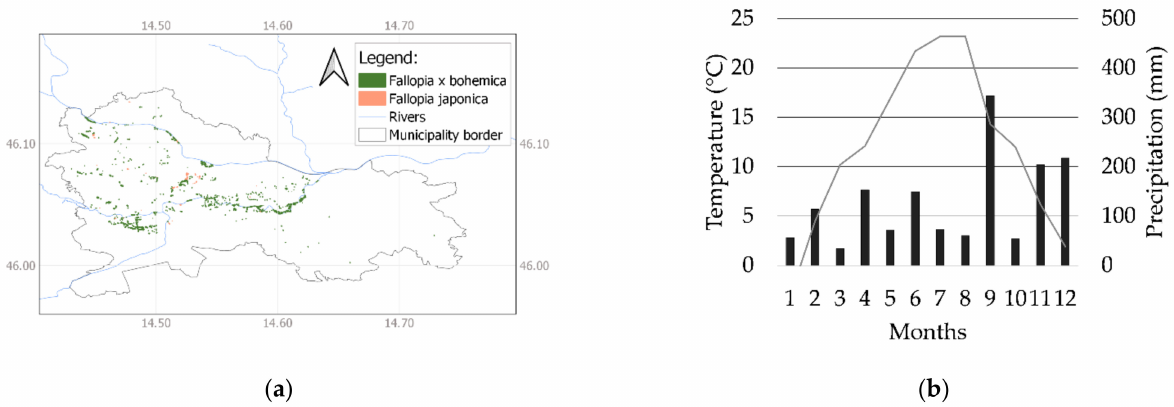
Figure 1. The ( a ) stands of F. japonica and F. × bohemica , and ( b ) average monthly air temperature ( ◦ C) (line) and precipitation (mm) (bars) in 2017 in Ljubljana